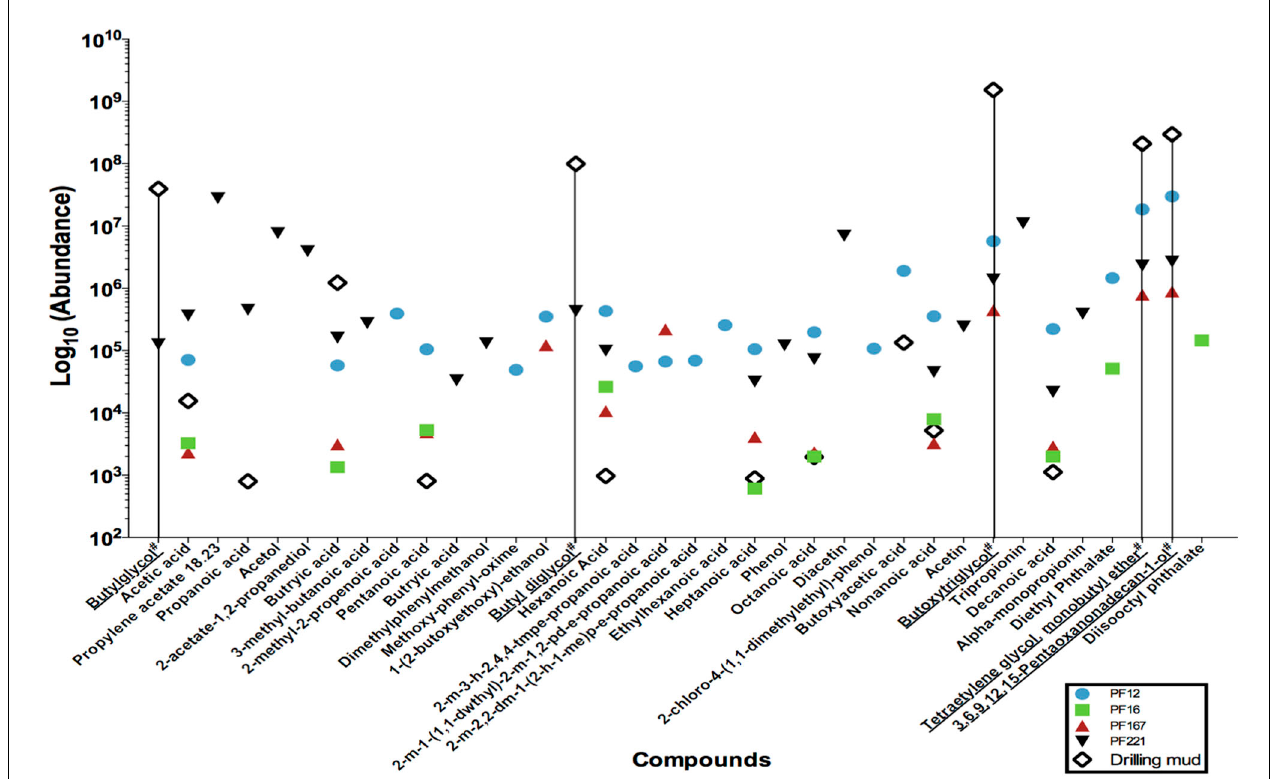
FIGURE 2 | Low molecular weight fatty acid analyses of a subset of pre-scSCO 2 , post-scCO 2 injection water samples and drilling mud samples. Subsets of groundwater samples were assessed for low molecular weight fatty acids by gas chromatography mass spectrometry. (#) Chemical names with an underline represent compounds belonging to the